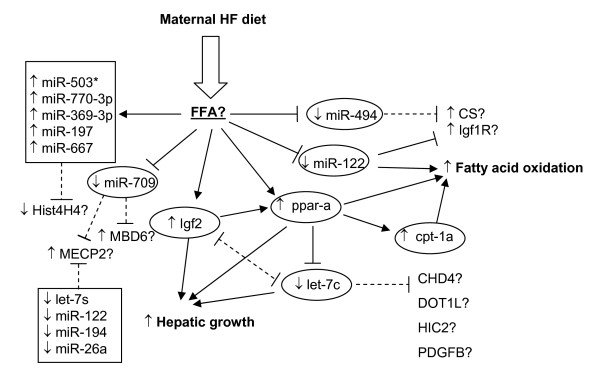
Maternal high fat diet during gestation and lactation alters hepatic expression of key genes and miRNAs in the offspring. A maternal HF diet during gestation and lactation increased hepatic Igf2 expression in the offspring, which may be required for the up-regulation of ppar-α/cpt-1a by HF diet as suggested by our data presented in the Table 2. Increased ppar-α suppresses expression of let-7c, facilitates hepatic growth. Igf2 could down regulate let-7c through increased expression of ppar-α. Increased expression of ppar-α and reduced expression of miR-122 may increase hepatic fatty acid oxidation in the offspring. Igf1 receptor (Igf1R) and citrate synthase (CS) are predicted targets shared by both miR-122 and miR-494. Inhibition of Igf1R has been confirmed very recently [86]. Similar to miR-122, maternal HF offspring have reduced miR-494 levels, which favour increased Igf1R and CS activities. Several key proteins involved in epigenetics are predicted targets for miRNAs, in particular, methyl-CpG binding protein 2 are predicted targets for 5 miRNAs (miR-709, let-7s, miR-122, miR-194 and miR-26a) showing reduced levels in maternal HF fed offspring. Histone 4 H4 are predicted targets for 5 miRNAs (miR-503*, miR-770-3p, miR-369-3p, miR-197 and miR-667) showing increased levels in maternal HF fed offspring. Arrows suggest stimulatory and blocked arrows inhibitory effects. Solid lines represent established relationships whereas broken lines represent relationships not yet confirmed experimentally. FFA: free fatty acids. CS: citrate synthase, ppar-a: peroxisome proliferator activated receptor-alpha, cpt: carnitine pamitoyltransferase, MBD: methyl-CpG binding domain protein, MECP2:Methyl-CpG-binding protein 2, CHD4:chromodomain helicase DNA binding protein 4, DOT1L: DOT1-like, histone H3 methyltransferase, HIC2: hypermethylated in cancer 2, Hist4H4, histone 4 H4.